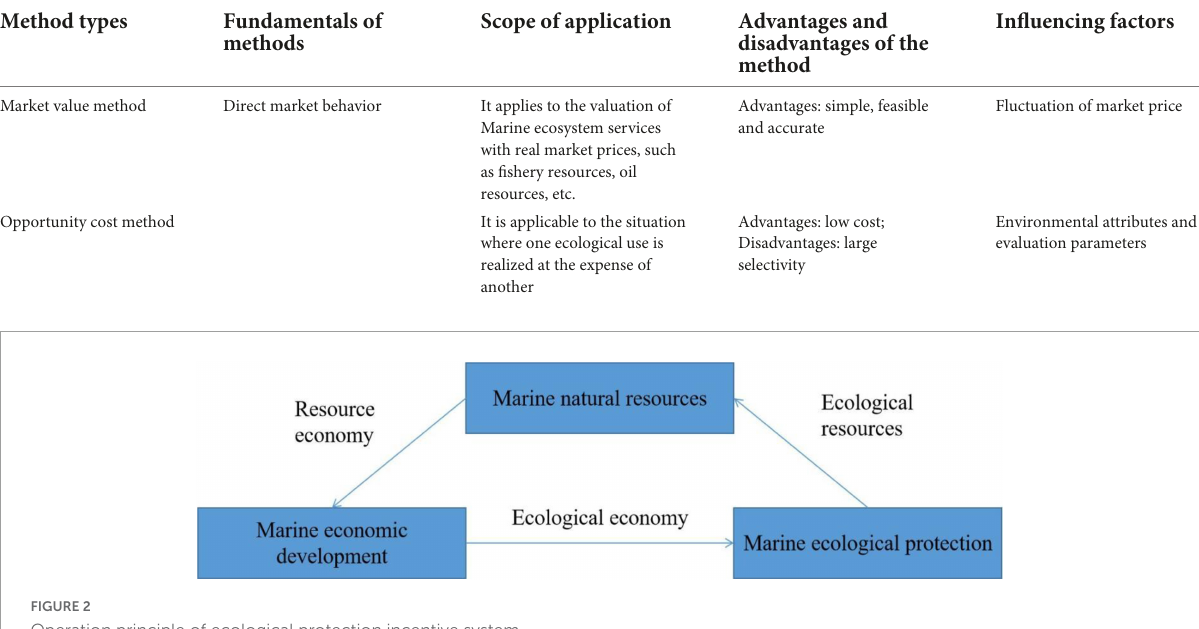
TABLE 5 Evaluation methods and characteristics of Marine ecosystem services value.